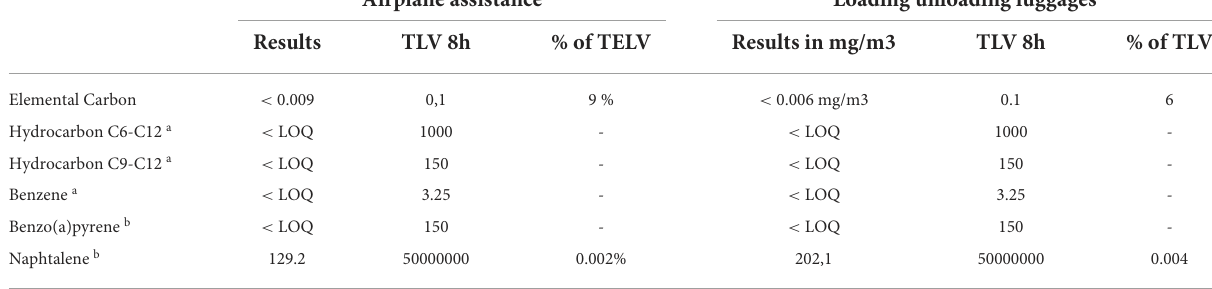
TABLE 3 Results of exposure assessment of airport workers and comparison to TLV 8h.